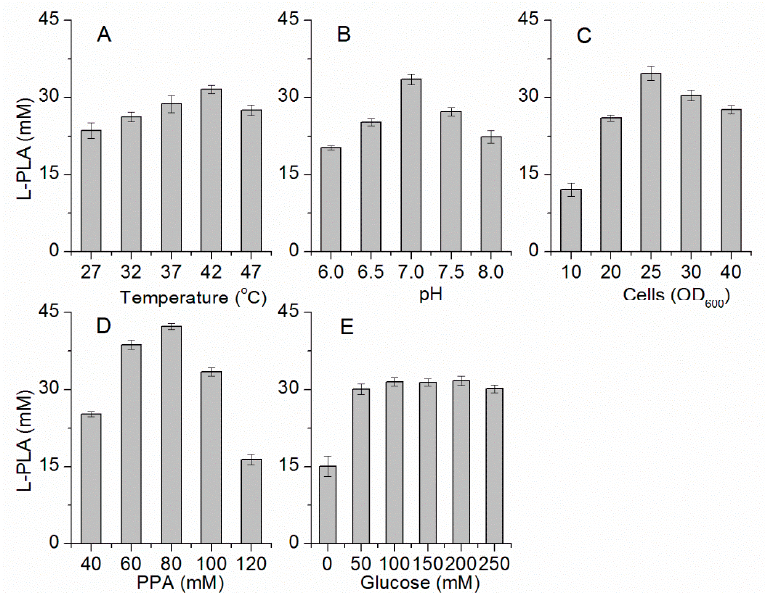
Figure 3. Optimization of bioconversion conditions. ( A ) Temperature; ( B ) pH; ( C ) Concentration of whole cells; ( D ) Concentration of PPA; ( E ) Concentration of glucose.